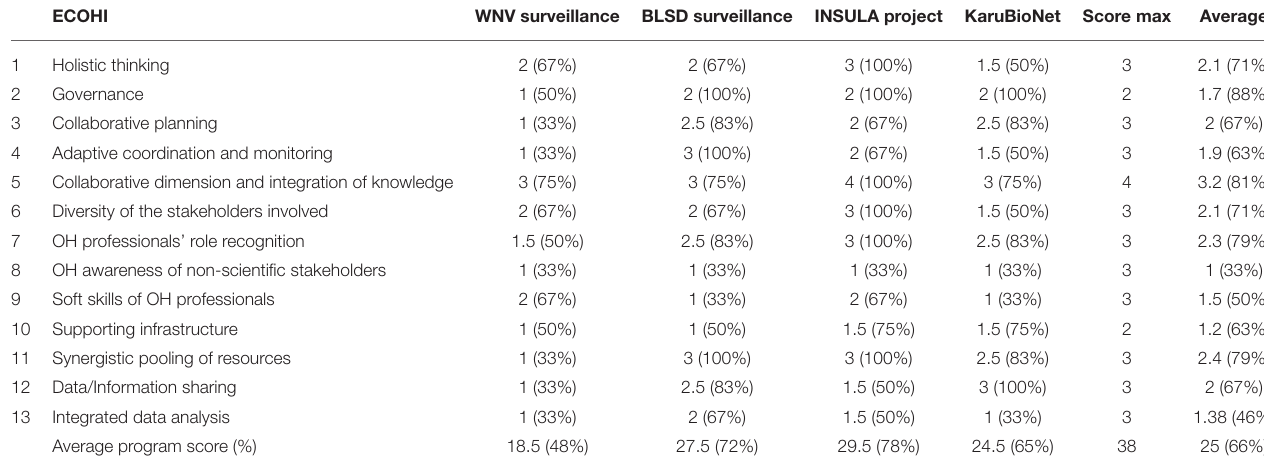
TABLE 4 | Scores obtained for each criterion and each initiative, with a total score also expressed in relative percentage (in bracket).